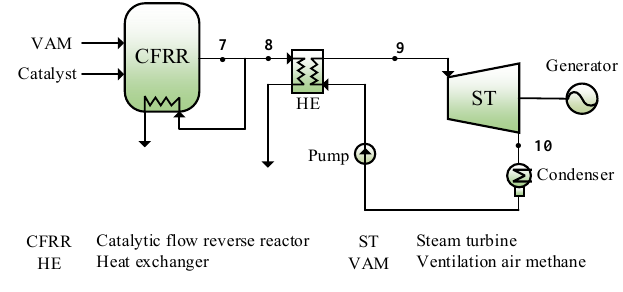
Figure 3. Schematic of the reference system II.